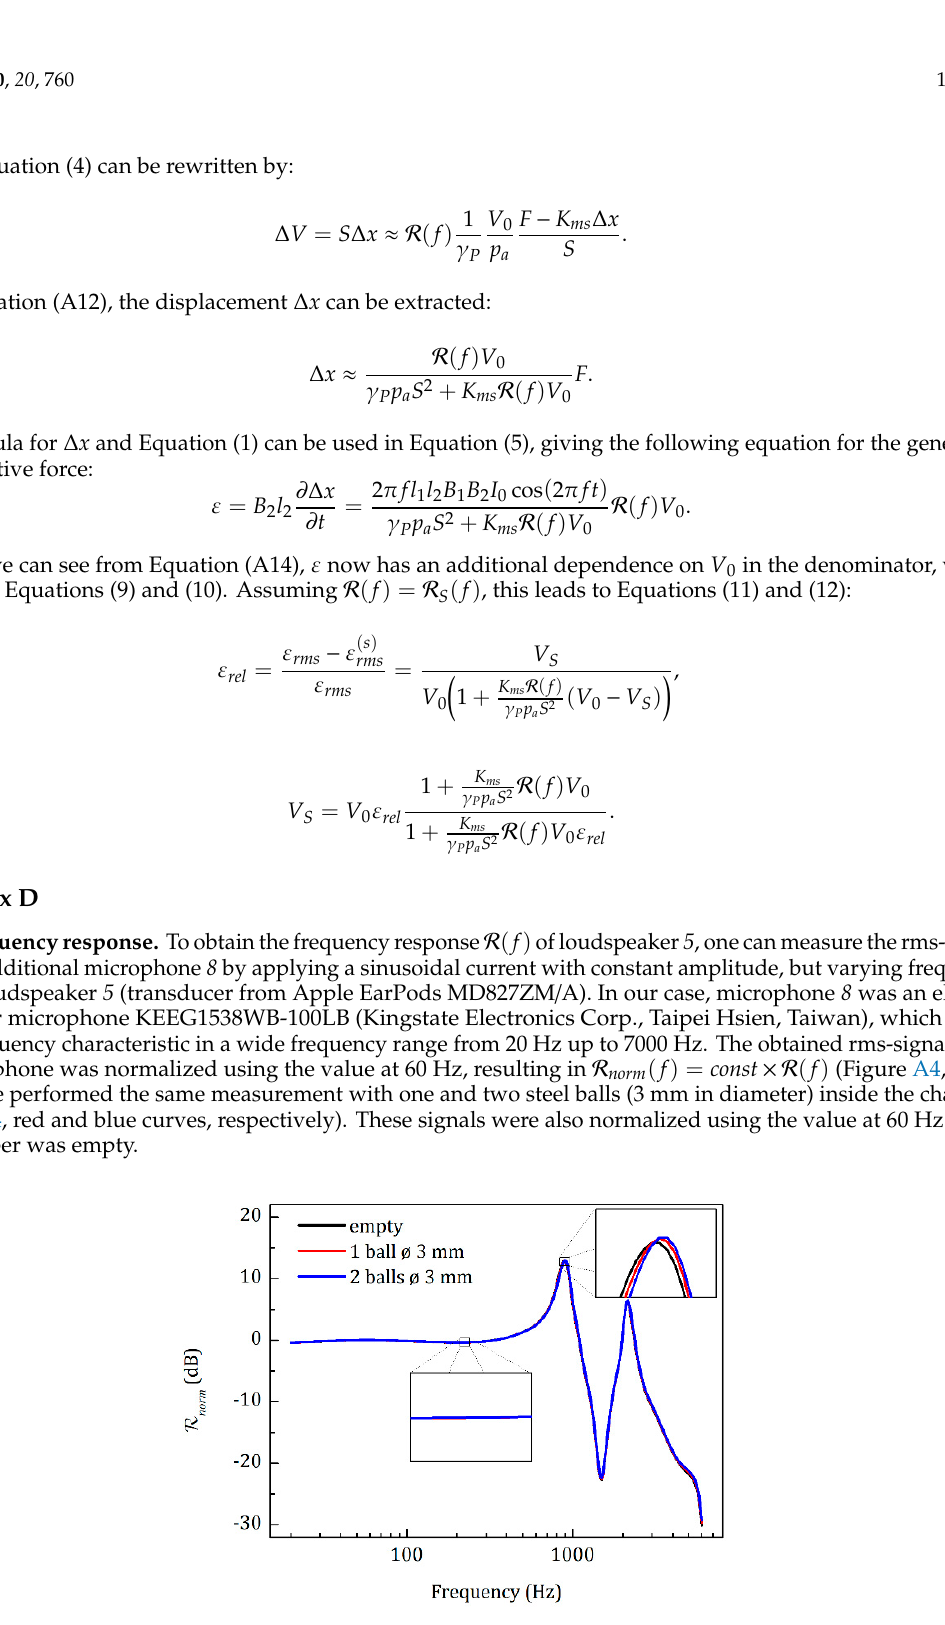
Figure A4. Normalized frequency response of loudspeaker 5 when chamber is empty (black curve), with one (red curve) and two (blue curve) balls 3 mm in diameter.